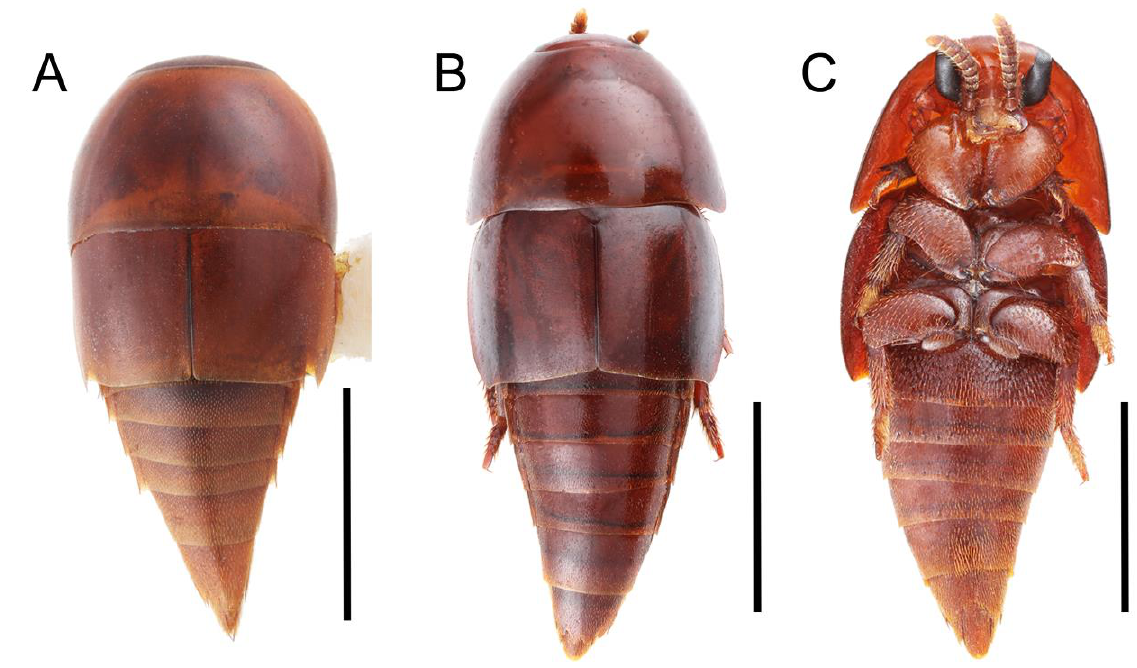
Figure 22. Habitus photographs of Vatesini ( Vatesus ). ( A ) Vatesus praedatorius Seevers, dorsal view. ( B ) Vatesus gigas (Wasmann), dorsal view. ( C ) Vatesus gigas , ventral view. Scale bars: 1.5 mm ( A ); 2.0 mm ( B , C ).